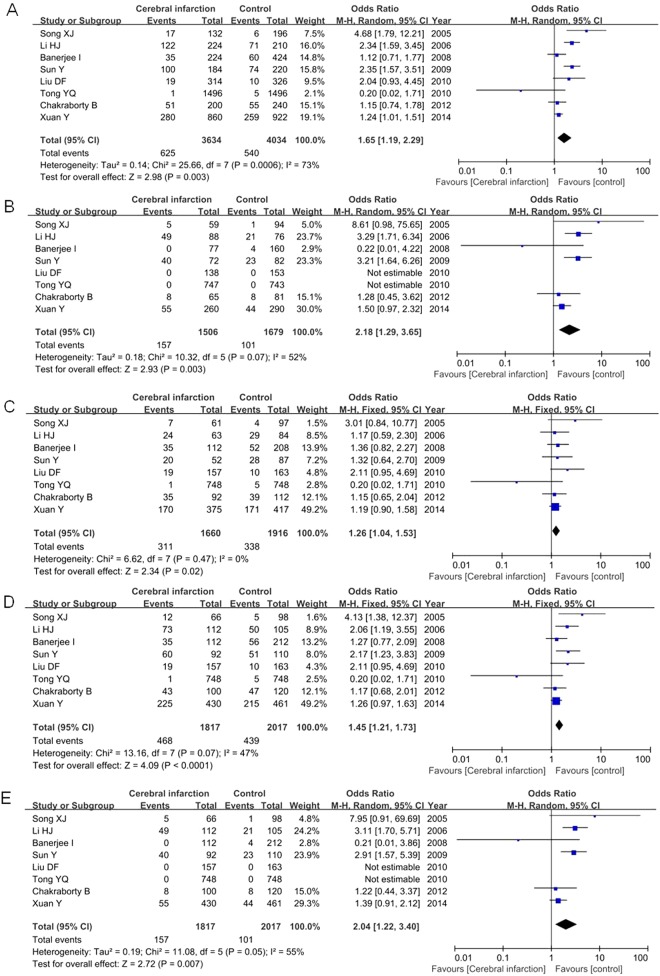
Forest plot of the relative strength of the association between IL-6 −174G/C polymorphism and cerebral infarction risk in Asians under the allelic model (A), homologous model (B), heterogeneous model (C), dominant model (D) and recessive model (E).